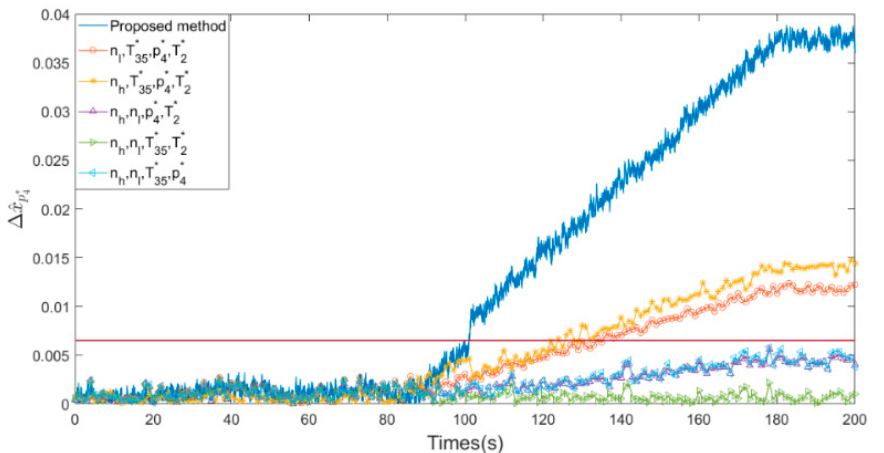
Figure 11. Comparison test of sensor FDI for 𝑝 (cid:2872)∗ drifting fault.